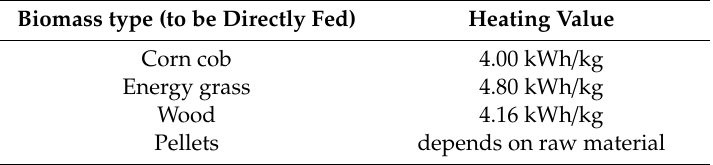
Table 7. Biomass types that can be directly fed into the biogas plant.